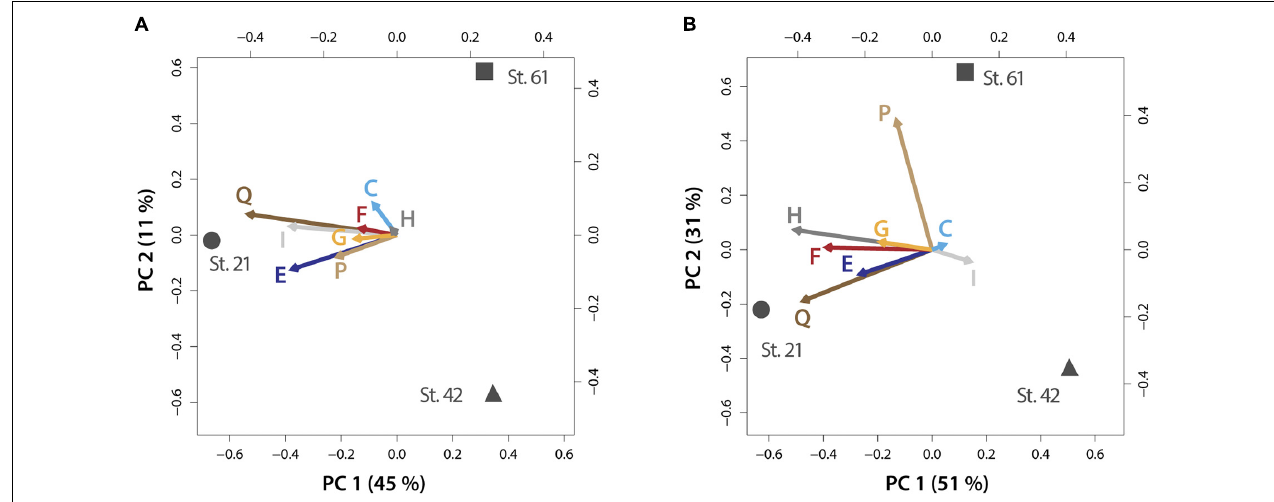
FIGURE 4 | PCA biplots on plasticity within metabolic processes for the micro-dinoflagellates (A) and the nano-dinoflagellates (B) . Vector lengths and direction indicate the influence on plasticity of the respective KOG-Category (abbreviated as letters) by environmental parameters prevailing at the respective stations. Letters codes for KOG-Categories are as in Figure 3 . Percentages of variance accounted for by each principal component are given in brackets.